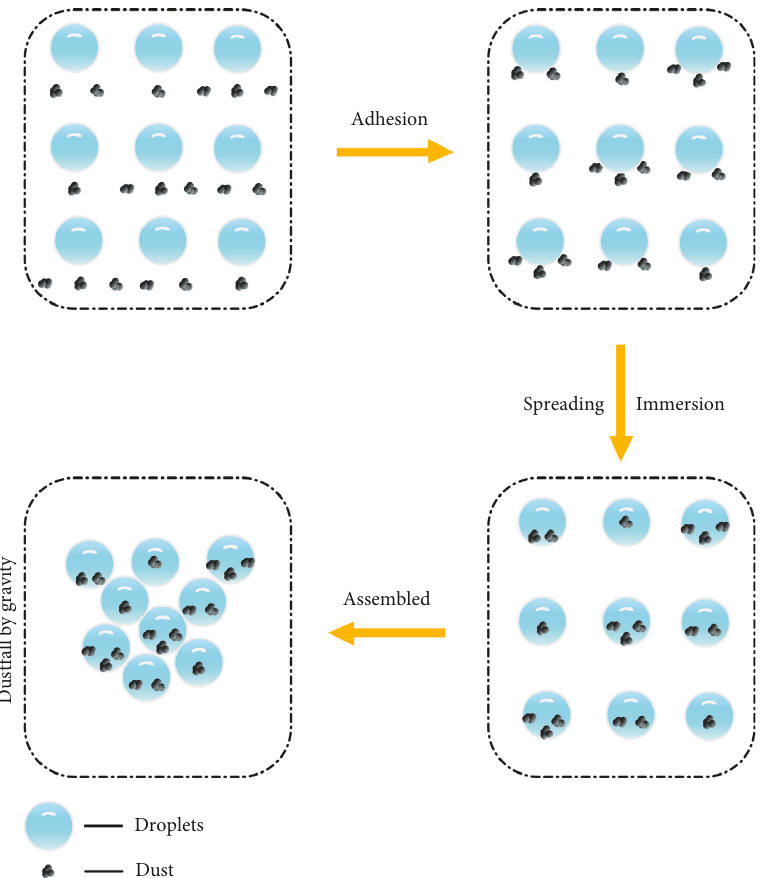
Figure 5: The process of the capture of dust particles capture by droplets.